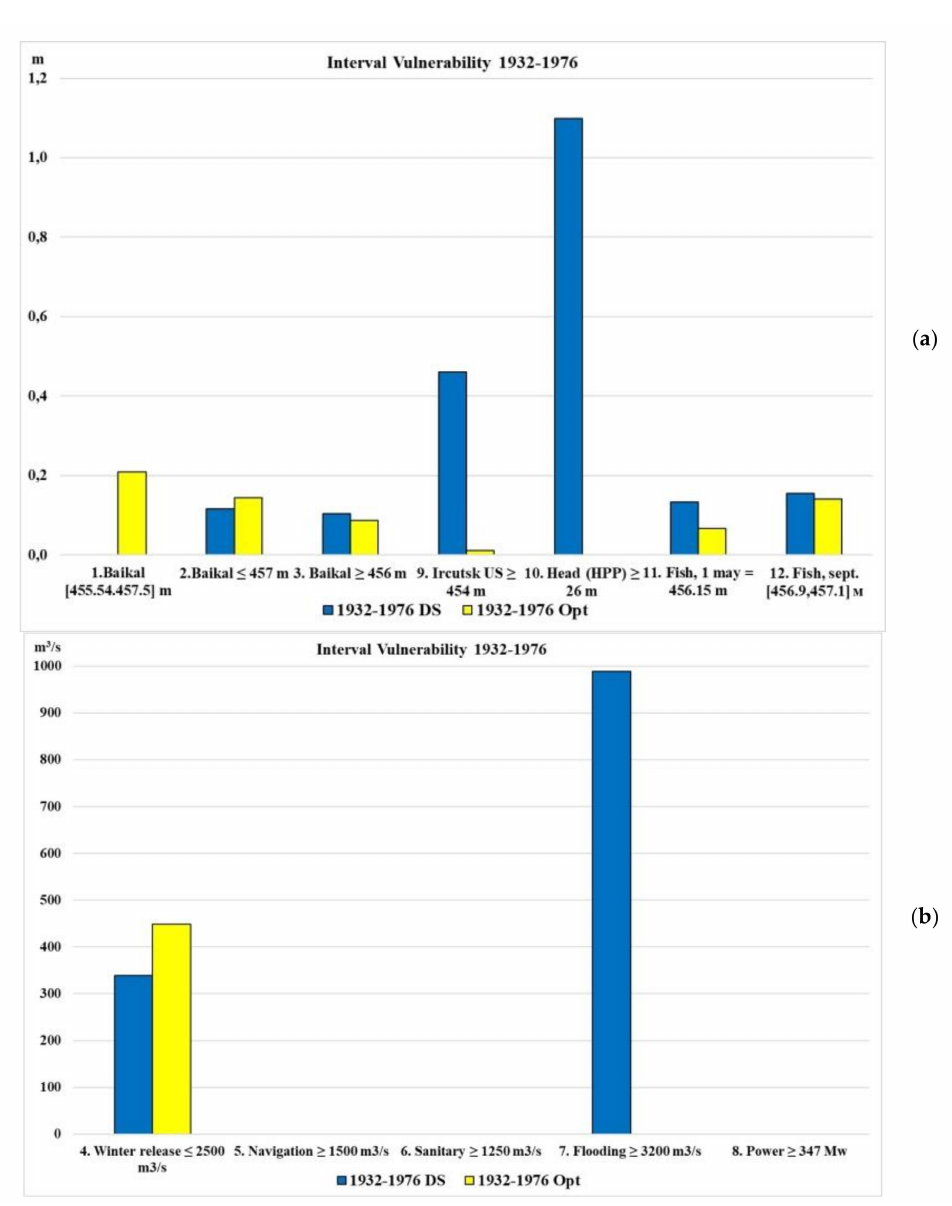
Figure 19. Interval vulnerability when WRC use DS and optimization (series 1932–1976) for criteria 1, 2, 3, 9, 10, 11, 12 ( a ) Figures 4–8, ( b